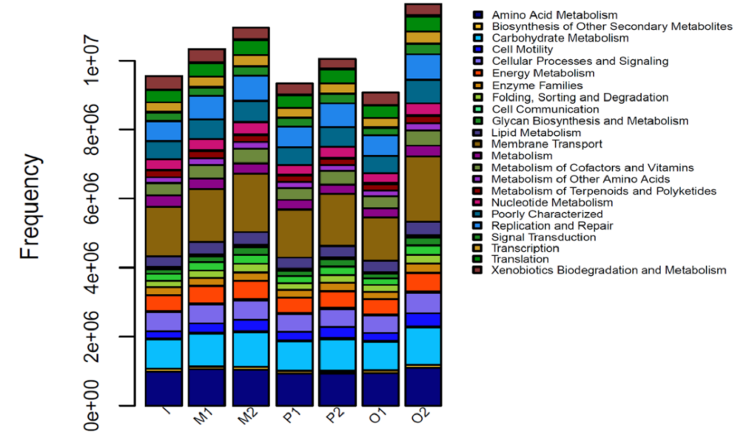
Figure 9. Distribution of functional structure based on KEGG.